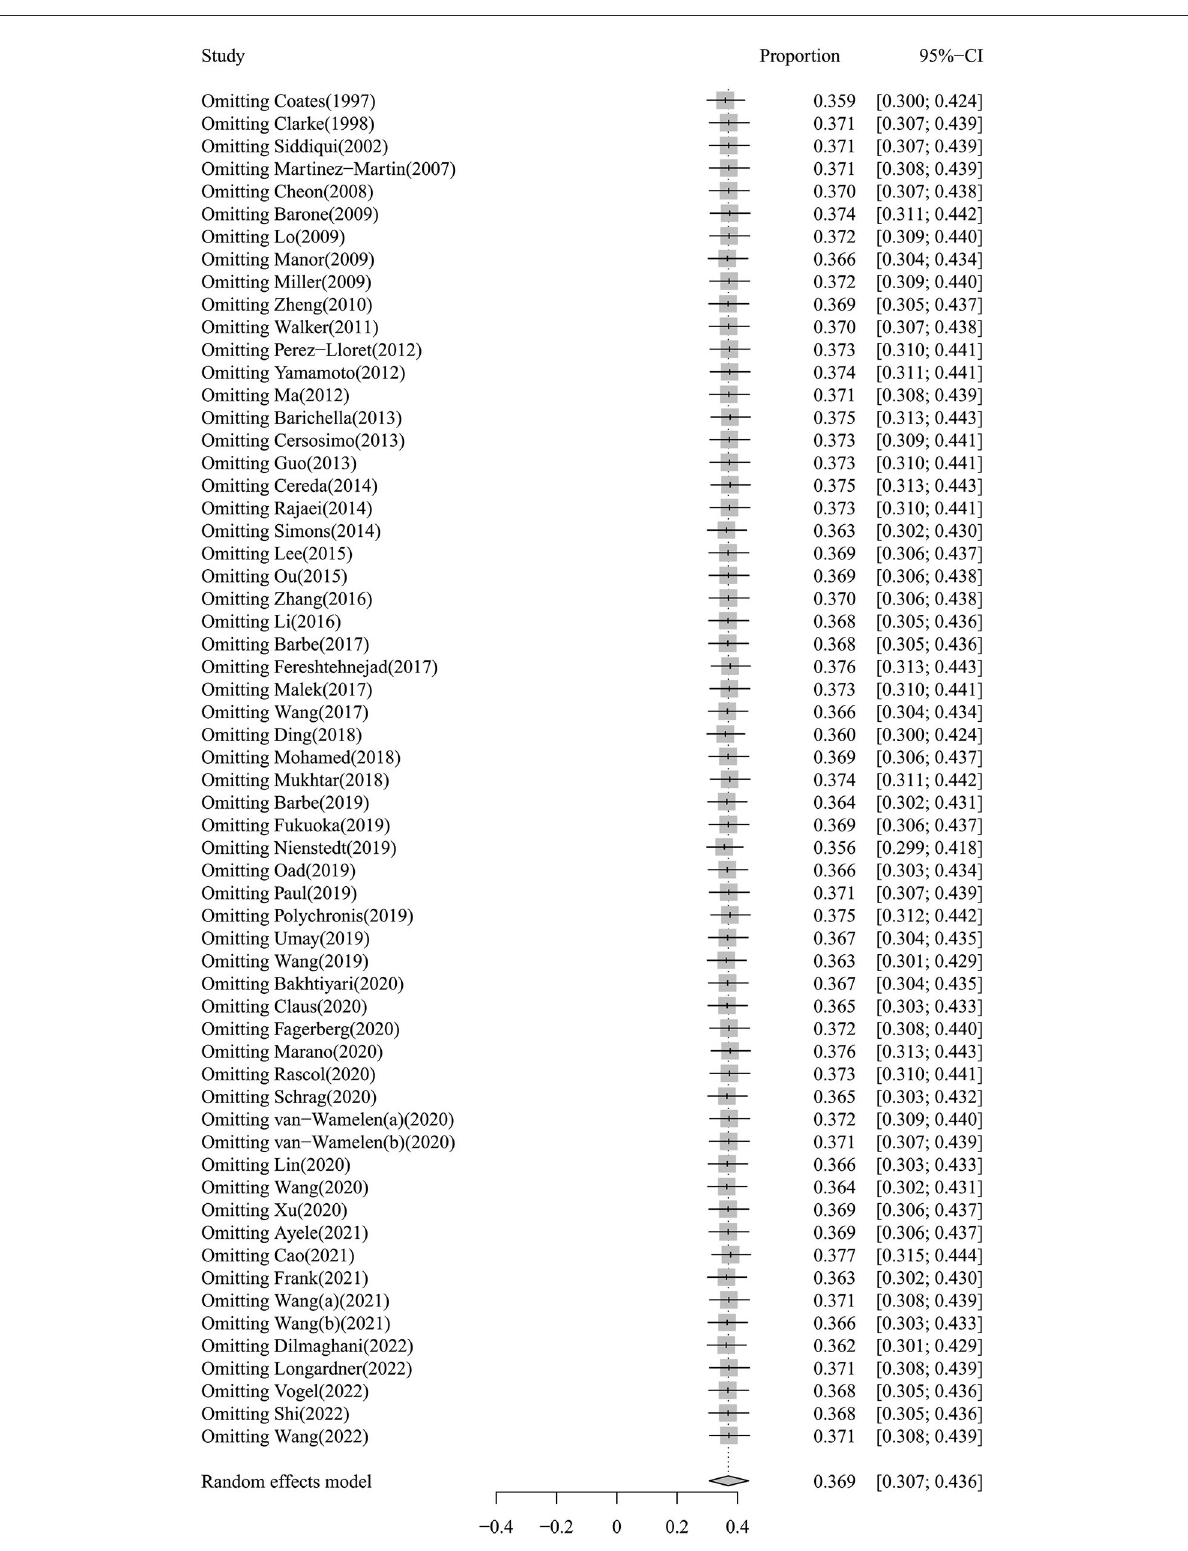
FIGURE3 The forest plot for sensitivity analysis of the prevalence of dysphagia in